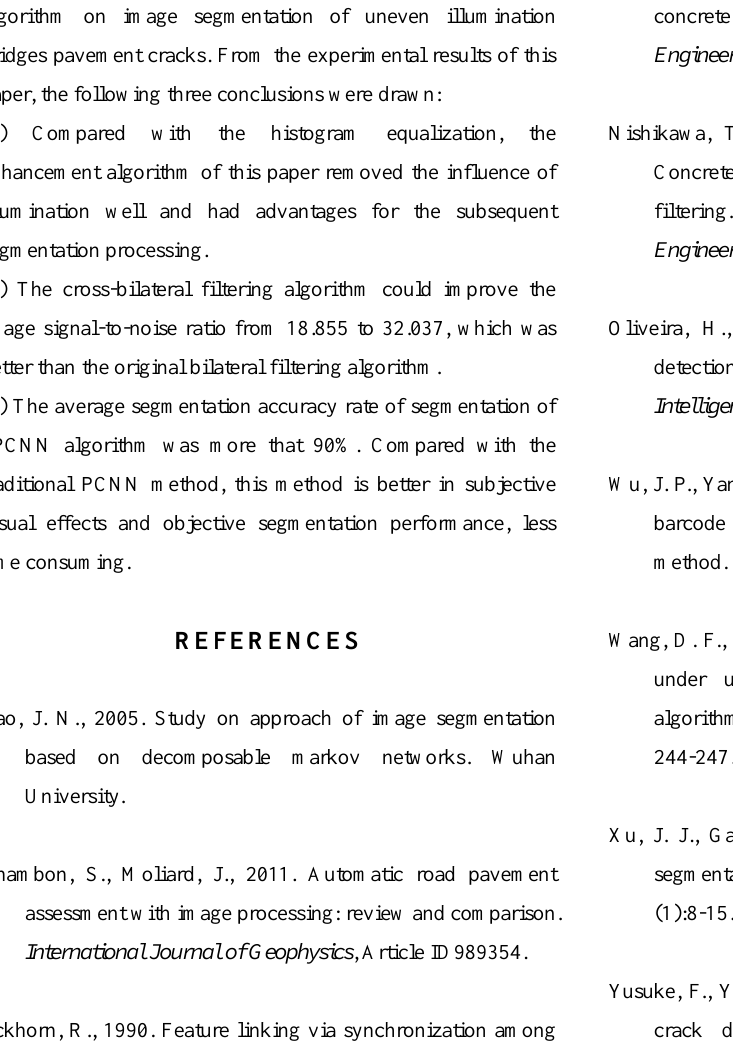
algorithm on image segmentation of uneven